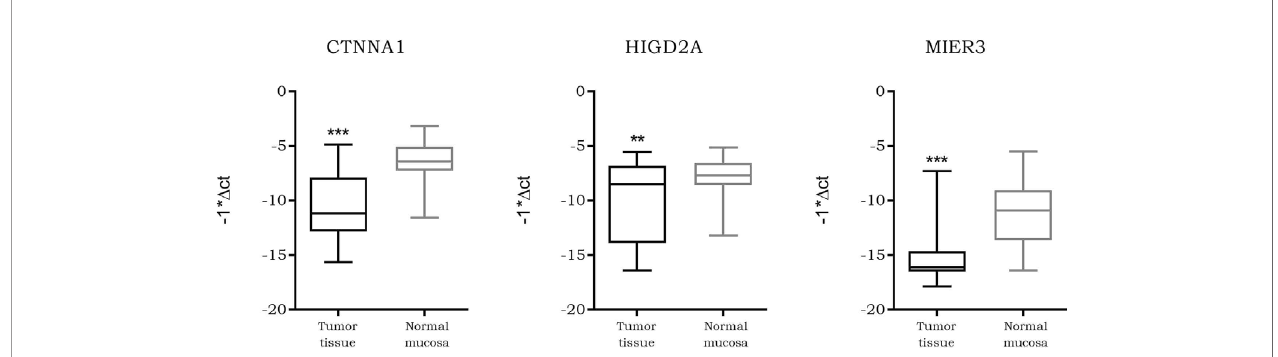
FIGURE 10 | Box plot showing the differential expression of CTNNA1, HIGD2A, and MIER3 in colorectal cancer (CRC) formalin- fi xed, paraf fi n-embedded ( FFPE) biopsies compared to normal adjacent mucosa. **p-value ≤ 0.01, ***p-value